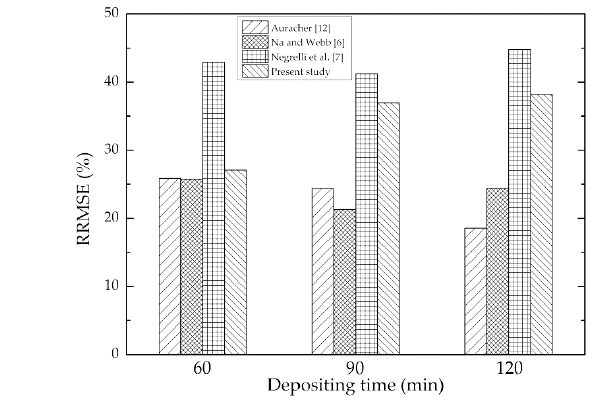
Figure 8. Comparison between experimental data and numerical results with correlations at 60 min.